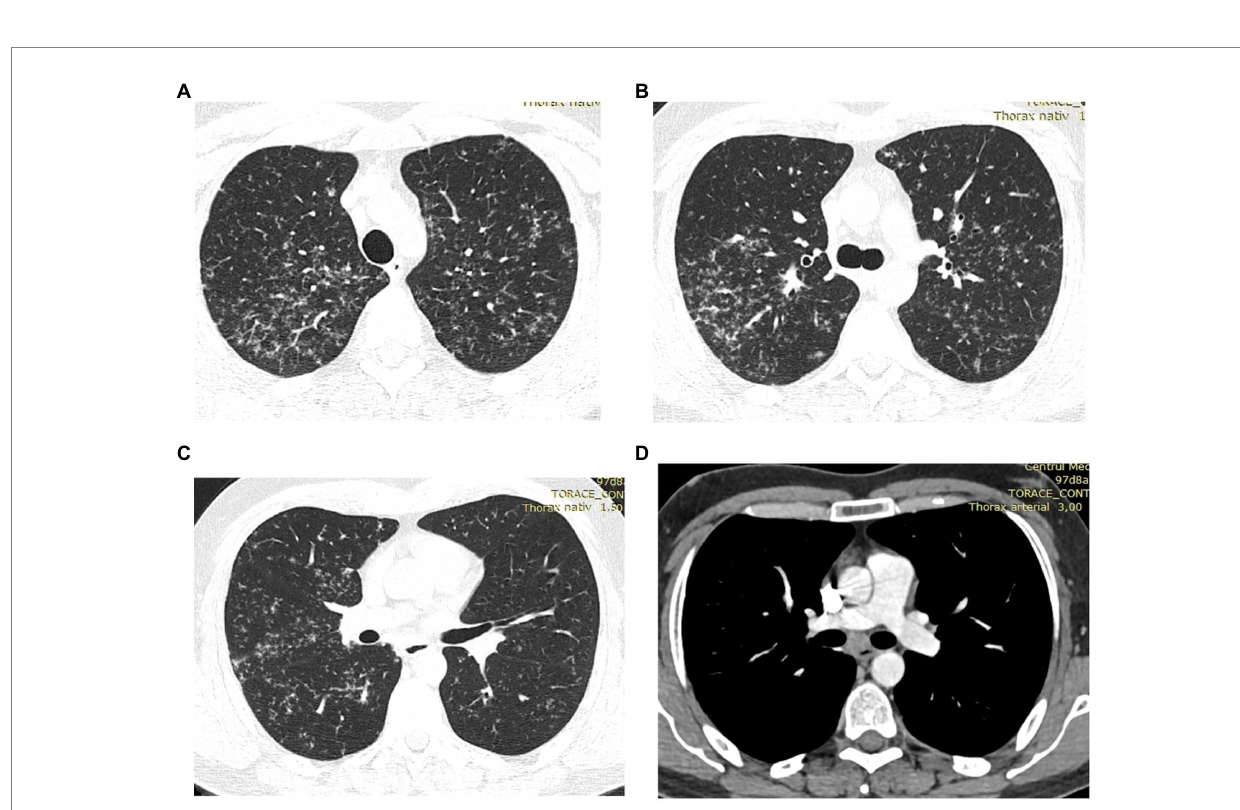
FIGURE 4 (A–D) HRCT of the lungs: multiple bilateral micronodules predominant in the upper lobes, increased infracarinal lymph nodes.